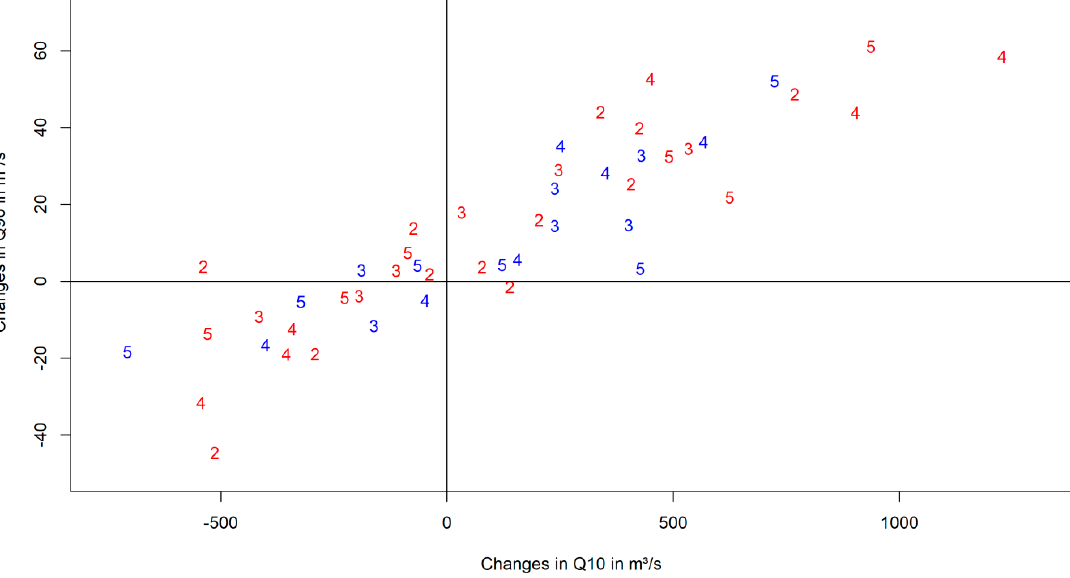
Figure 13. Scatterplot to visualize changes in Q10 and Q90 for each model and both RCP scenarios. Numbers represent the specific decades, whereas a “2” represents model simulations for the 2020s, continuing in this fashion up until the 2050s, represented with a “5”. Blue numbers represent RCP4.5 simulations and red numbers RCP8.5 scenario simulations.